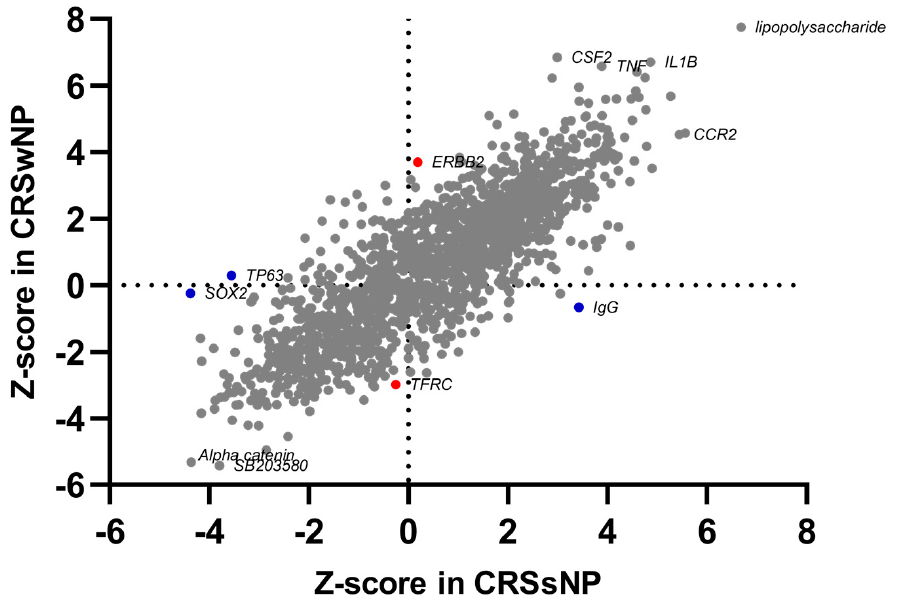
Figure 3. Comparison of enriched upstream regulators in CRSwNP and CRSsNP. The plot is based on the Z-score calculations obtained for a given set of genes, using the IPA analysis. A positive Z- score represents strongly activated (Z-score > 2) pathways, and a negative Z-score represents signif- icantly inhibited (Z-score < − 2) pathways. Proposed unique phenotype-associated pathways are pre- sented in red ( ● ) for CRSwNP and in blue ( ● ) for CRSsNP. Details in Supplementary Table S3 (Ca- nonical pathways).